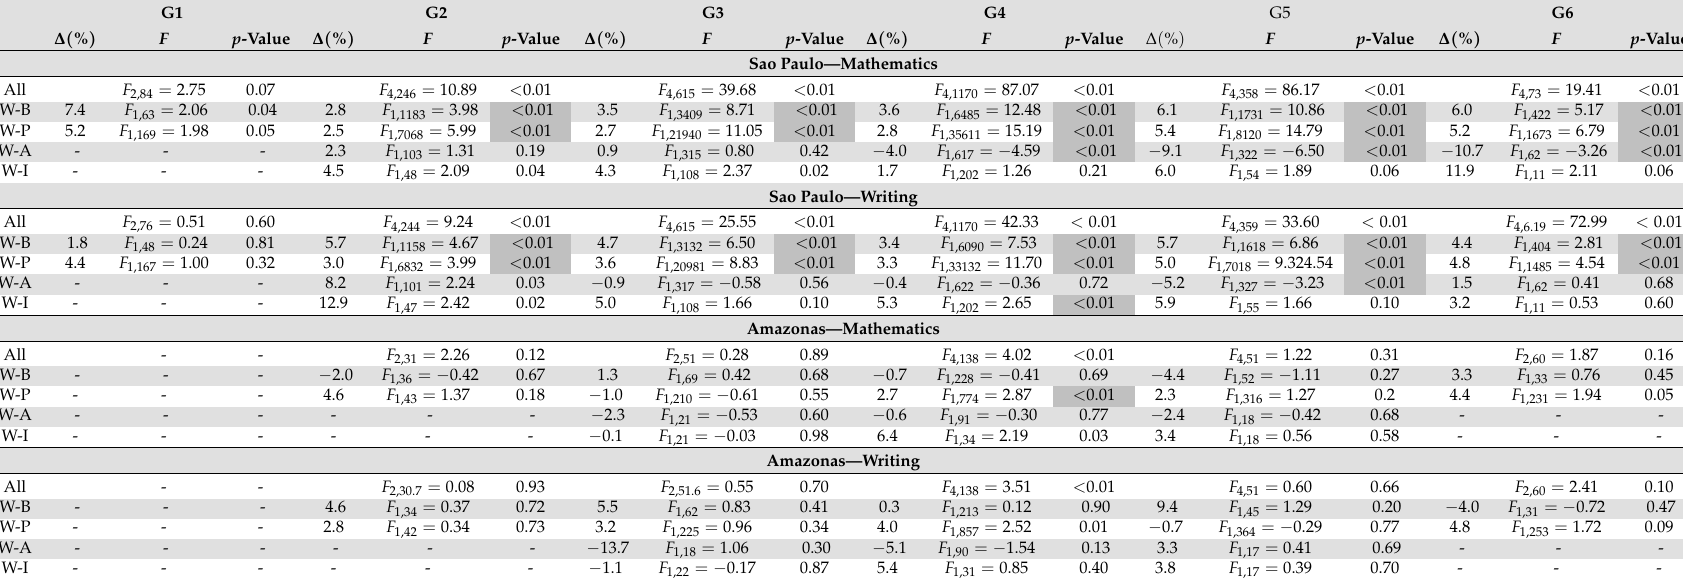
Table 2. Difference in the mean performance scores ( ∆ ) between ethnic categories and statistical significance of this difference ( p -value) for six parental education levels (G1 to G6). The ethnic categories are White (W), Black (B), Pardo (P), Asian (A) and Indigenous (I). All means that all ethnic categories are compared together. Dark gray cells highlight cases where p < 0.01 and “-” indicates that no statistics were taken because of the sample size. G1 G2